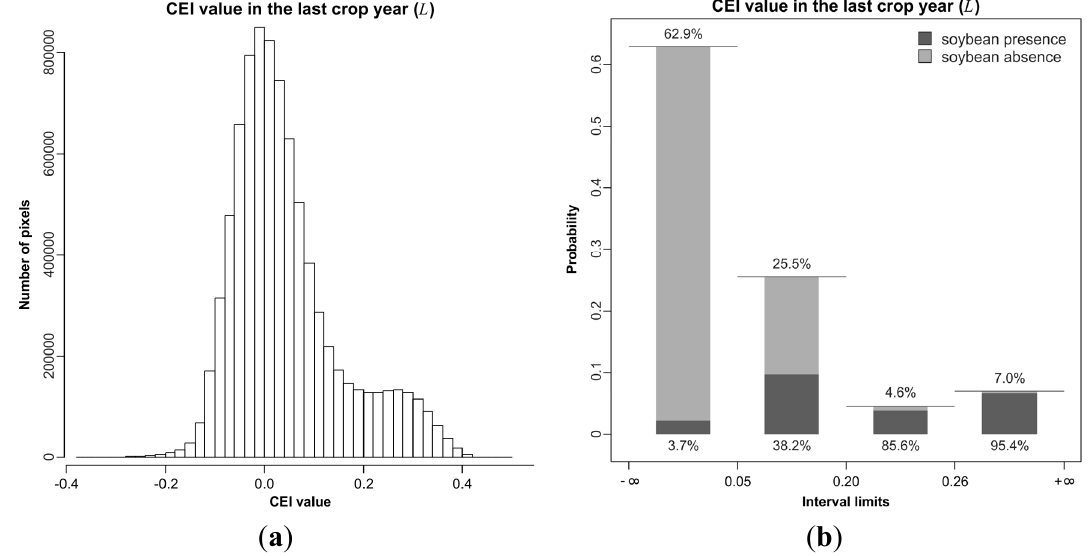
Figure 6. ( a ) Histogram of context variable CEI value in the last crop year ( L ); ( b ) Discretization of L into four intervals. The percentage at the top of each bar represents the probability of finding a pixel within the defined interval limits, e.g., P(0.26 ≤ L = l < + ∞ ) = 7.0%; and the percentage at the bottom of each bar represents the conditional probability of soybean presence given the defined interval limits for L , e.g.,